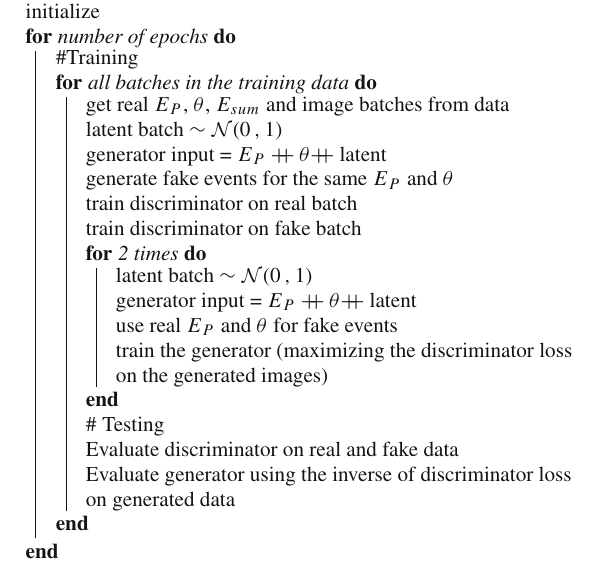
Algorithm 2: Training the 3DGAN